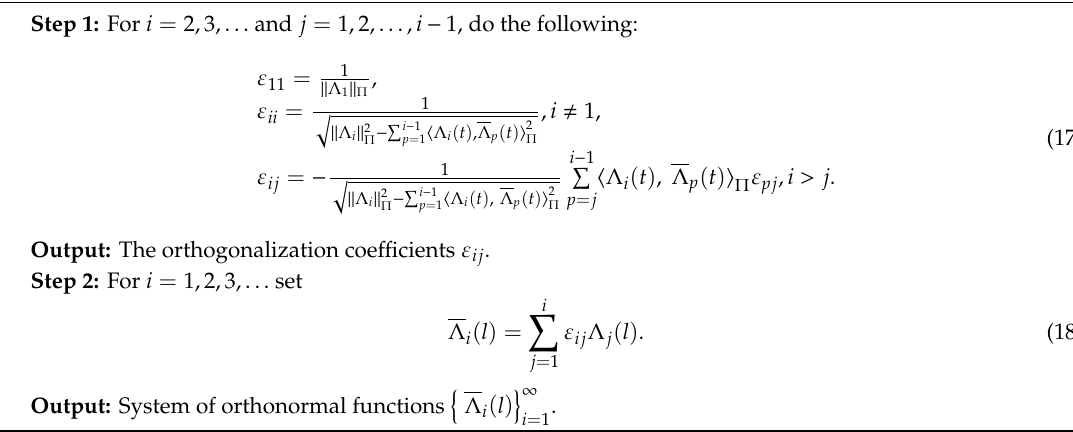
Algorithm 1. Steps of the orthonormal Gram–Schmidt